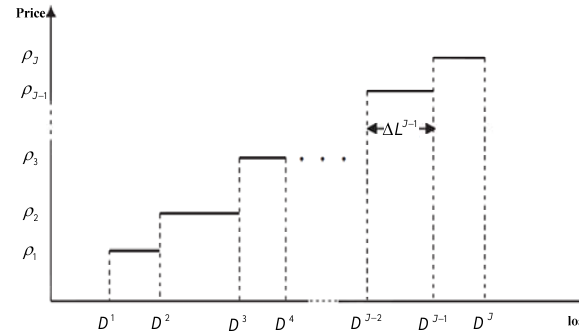
Figure 2. Step-wise DR price-demand curve.